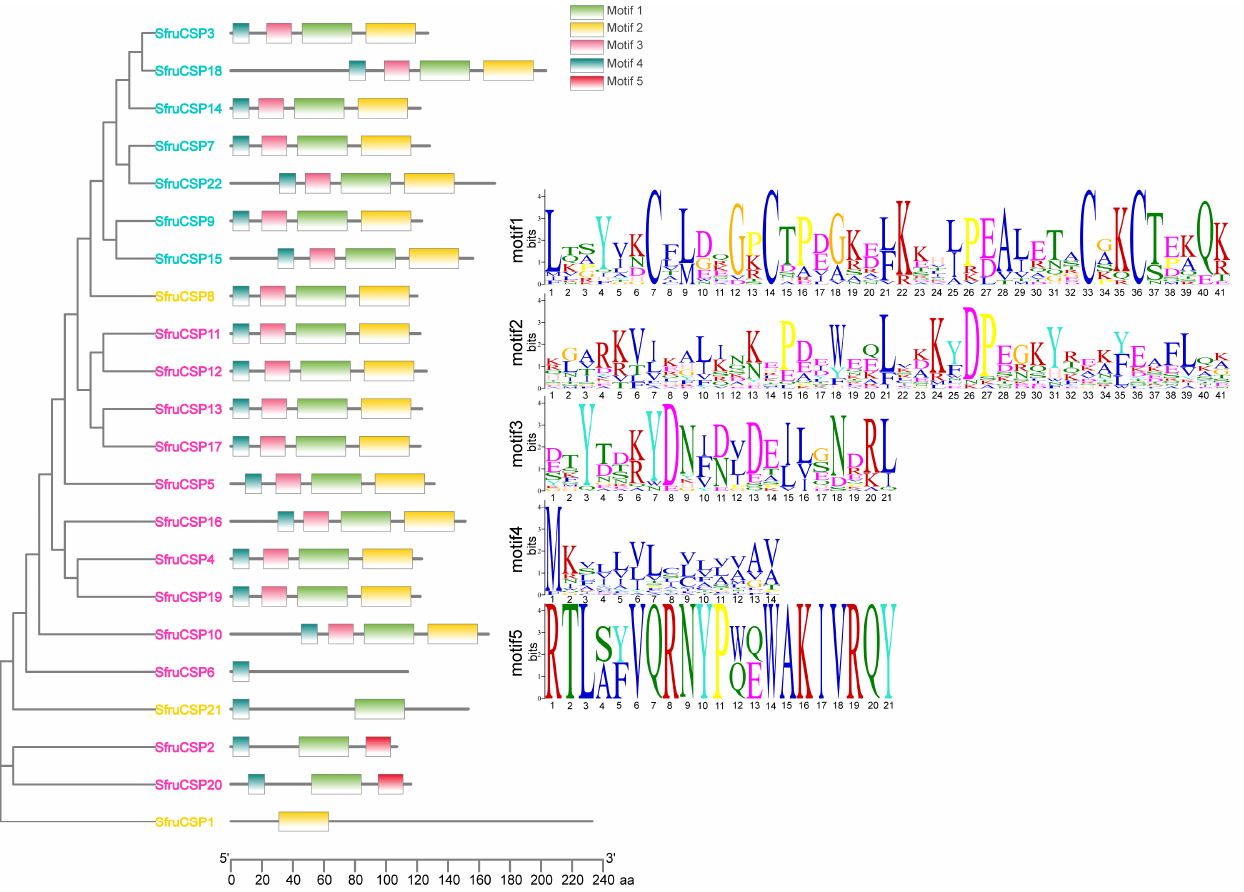
Figure 8. Motif distribution of SfruCSPs . Different motifs are represented by different colors, and the x ‐ axis represents the length of the proteins. The SeqLogo of motifs is predicted with the MEME online tool. Different colors of gene names indicate CSPs from specific clusters as indicated in Figure 2: orange, Cluster 1; pink, Cluster 2; bright green, Cluster 3; cyan, Cluster 4.